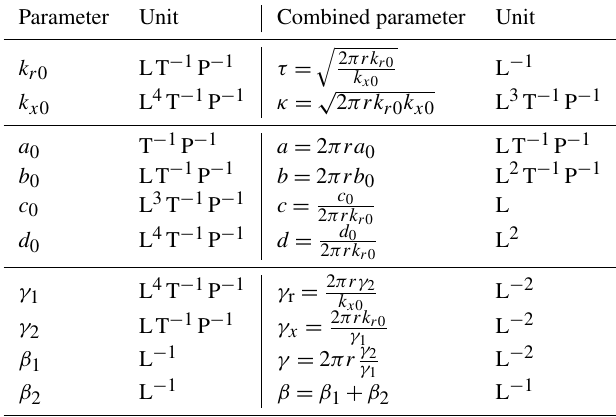
Table 3. Local hydraulic property function parameters, their units, the expression of combined parameters and their corresponding units. Parameter